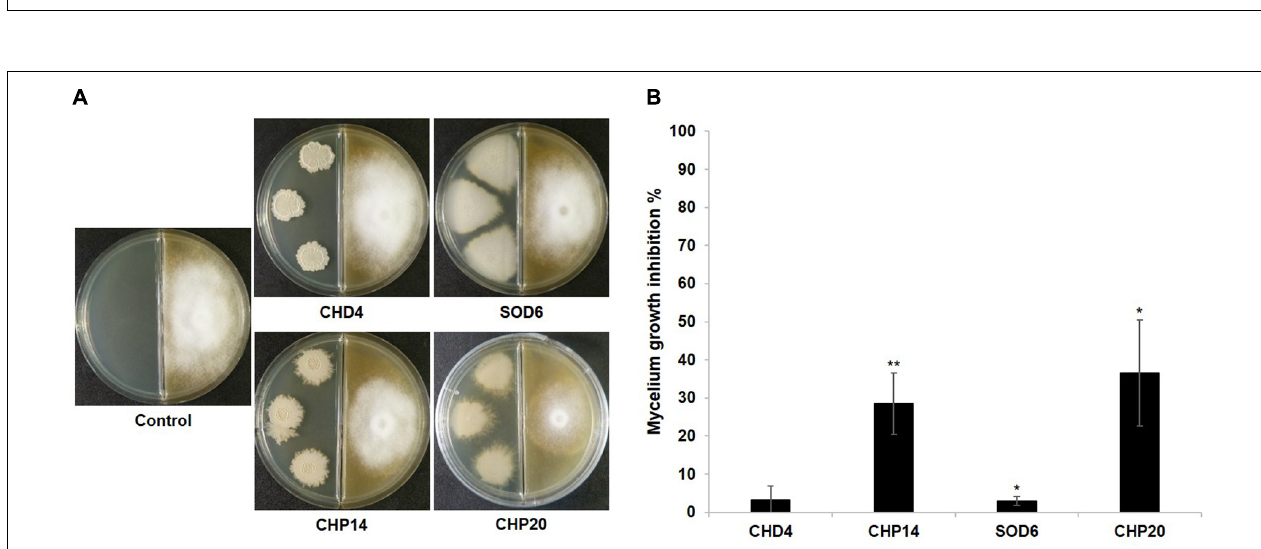
FIGURE 8 | Volatile-mediated growth inhibition of P. infestans by selected strains. Representative pictures of dual assays with P. infestans non-exposed to the bacteria (Control) or exposed to four bacterial strains isolated from the grapevine microbiome are shown in (A) . The pictures were taken 2 weeks after P. infestans inoculation. The percentage of P. infestans mycelium inhibition induced by each strain compared to the non-exposed control that represents 100% is shown in (B) . Bars represent average inhibitions of 3–5 replicates with standard deviation. The percentage of inhibition was determined 2 weeks after P. infestans inoculation. Asterisks represent statistically significant differences in comparison to the control ( t -test; ∗ p < 0.05; ∗∗ p < 0.01).